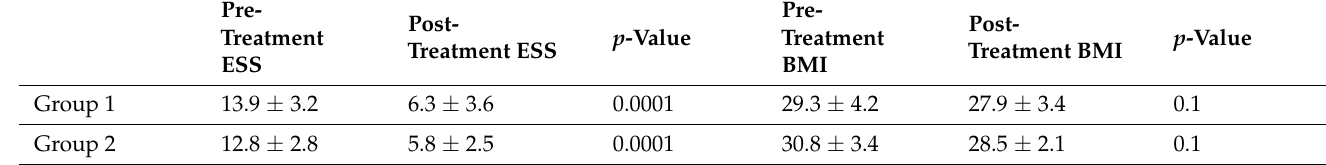
Table 4. Statistical difference between pre- and post-treatment sleep apnea respiratory outcomes.